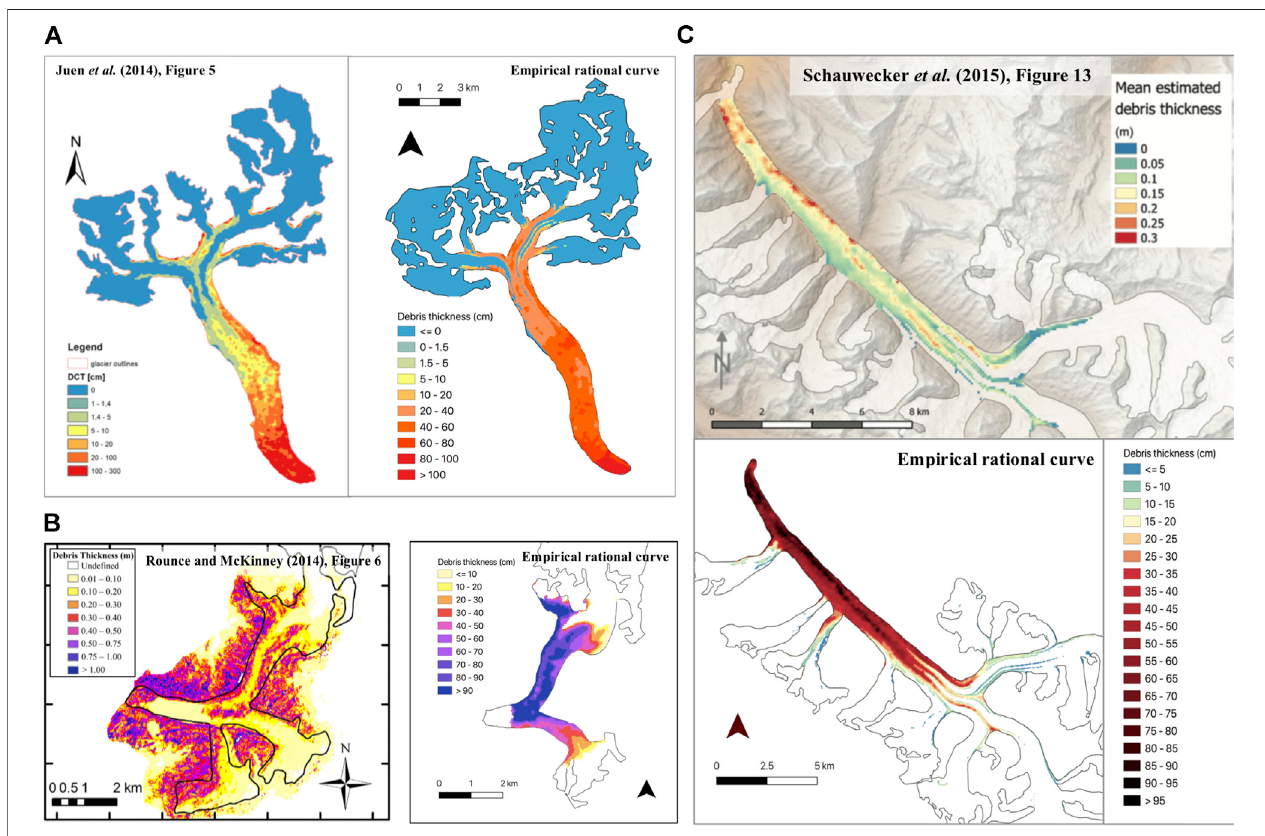
FIGURE 7 | Derived debris thickness distributions for the debris-covered parts of (A) Koxkar Glacier (UTM 44N), (B) Imja-Lhotse Shar Glacier (UTM 45N), and (C) Bara Shigri Glacier (UTM 44N), in comparison to published maps of derived debris thickness.